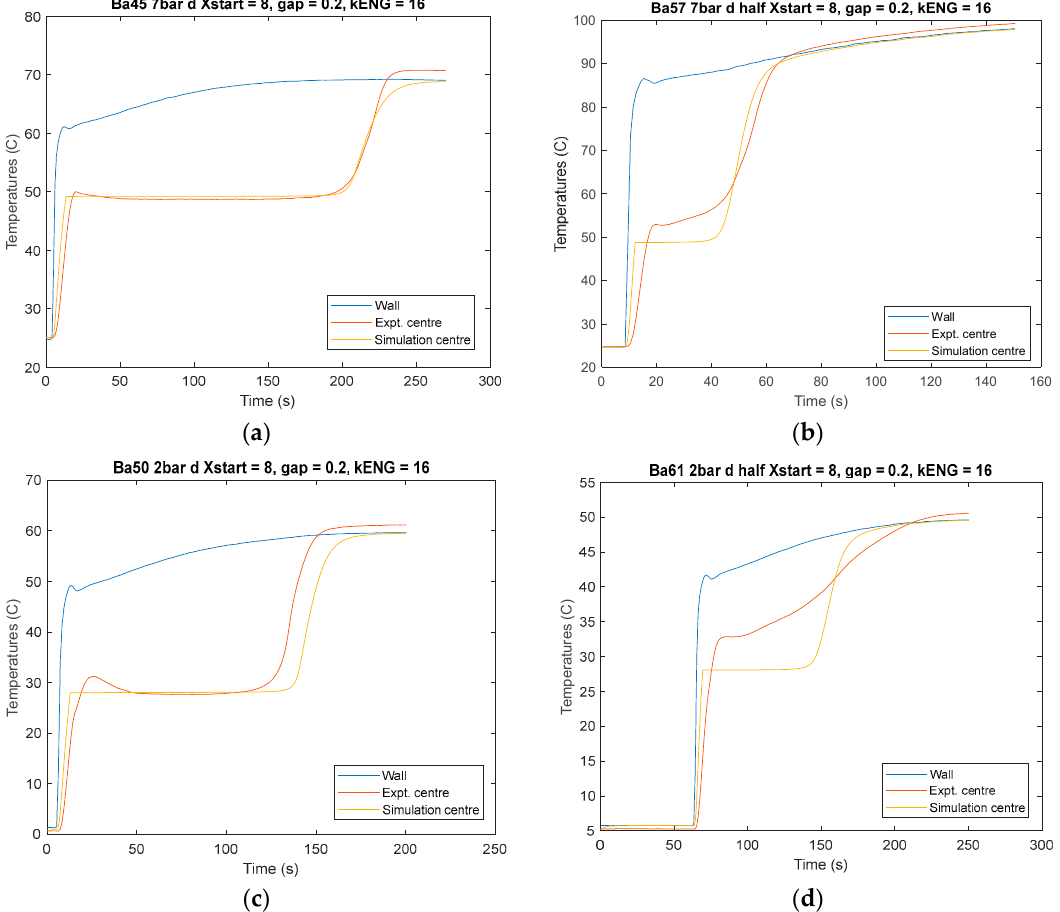
Figure 5. Model results versus measured results for desorption reaction: ( a ) approx. 7 bar with 0.531 kg salt/kg of composite; ( b ) approx. 7 bar with 0.317 kg salt/kg of composite; ( c ) approx. 2 bar with 0.531 kg salt/kg of composite; ( d ) approx. 2 bar with 0.317 kg salt/kg of composite.